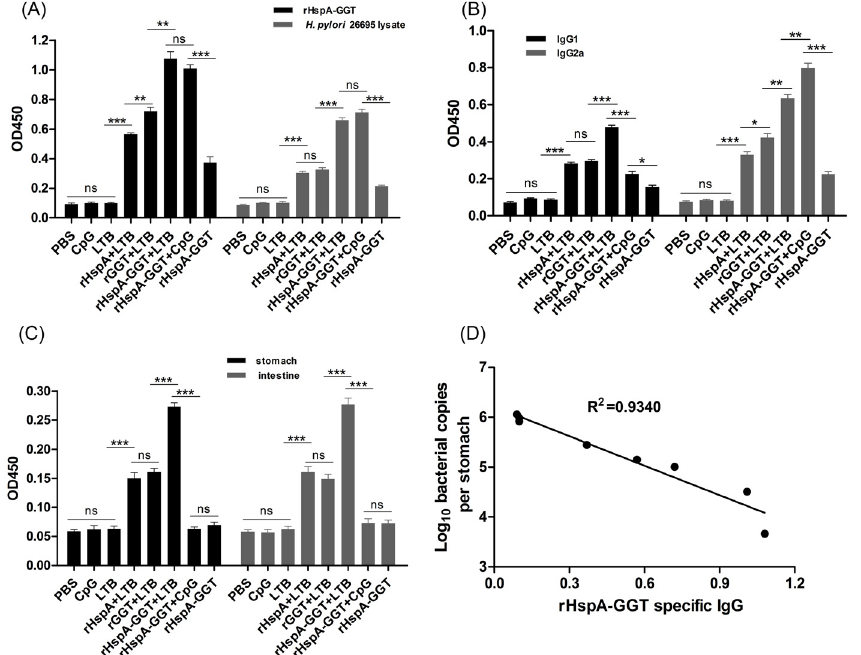
Fig 3. Antigen specific antibody responses elicited by immunization. Two weeks after immunization, mice in each group (n = 5) were bled and the sera were collected for analysis of the specific IgG antibody and its subtype. (A) Specific IgG antibody titers, for antibodies raised against rHspA-GGT and H . pylori 26695 lysate, were measured by ELISA. (B) The levels of specific IgG1 and IgG2a, against rHspA-GGT, were determined from serum samples tested by ELISA. (C) Immunized mice were sacrificed 4 weeks after challenge and the supernatants of homogenized stomachs and intestines were collected for detection of specific sIgA levels, against rHspA-GGT. Data are presented as mean ± S.D (n = 5). (D) Regression analysis of bacterial loads and the level of rHspA-GGT specific serum IgG. ** P < 0.01 compared with indicated groups, *** P < 0.001 compared with indicated groups, ns: not